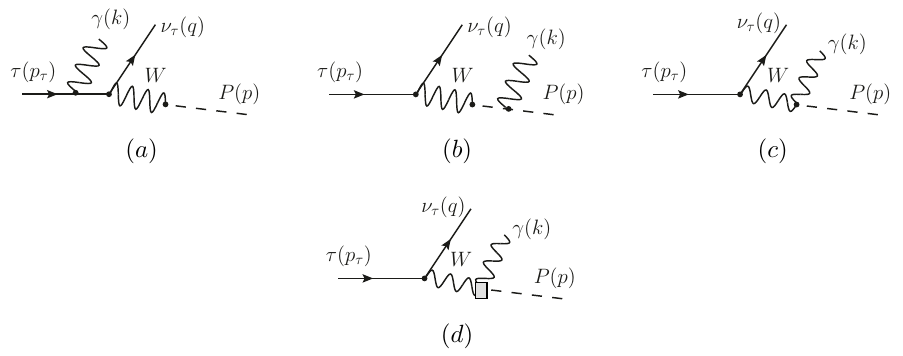
Figure 1 . Feynman diagrams for real-photon corrections in one-meson tau decays. The first three diagrams (a), (b), (c) stand for the inner bremsstrahlung contribution, which is model independent (structure-independent). The gray box in diagram (d) represents the structure-dependent contribu- tions including the vector and axial